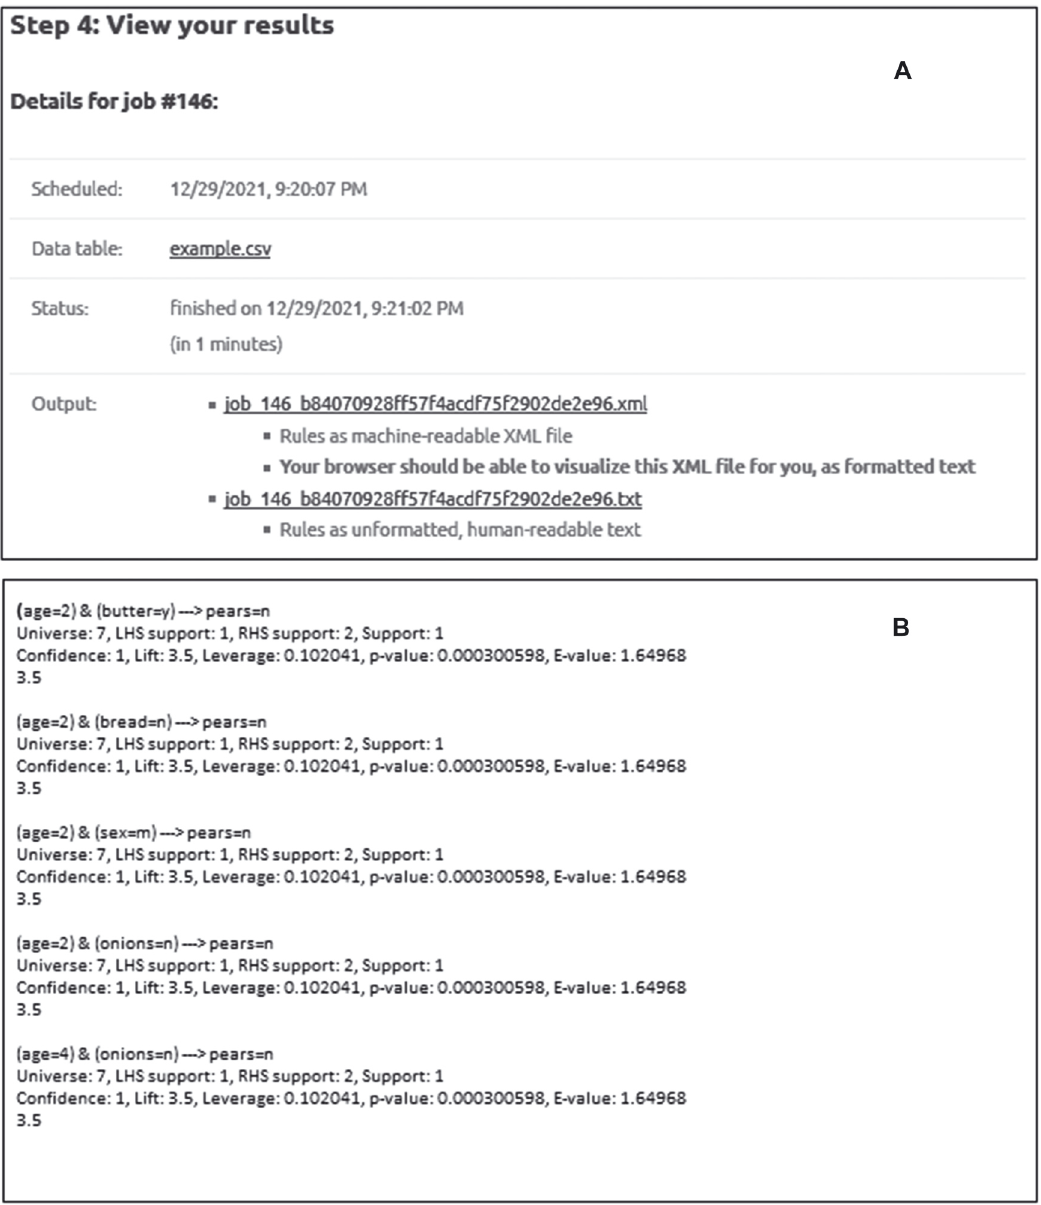
Figure 3: The output screen of the webserver (panel A) and a partial output with five discovered rules found in the example dataset (panel